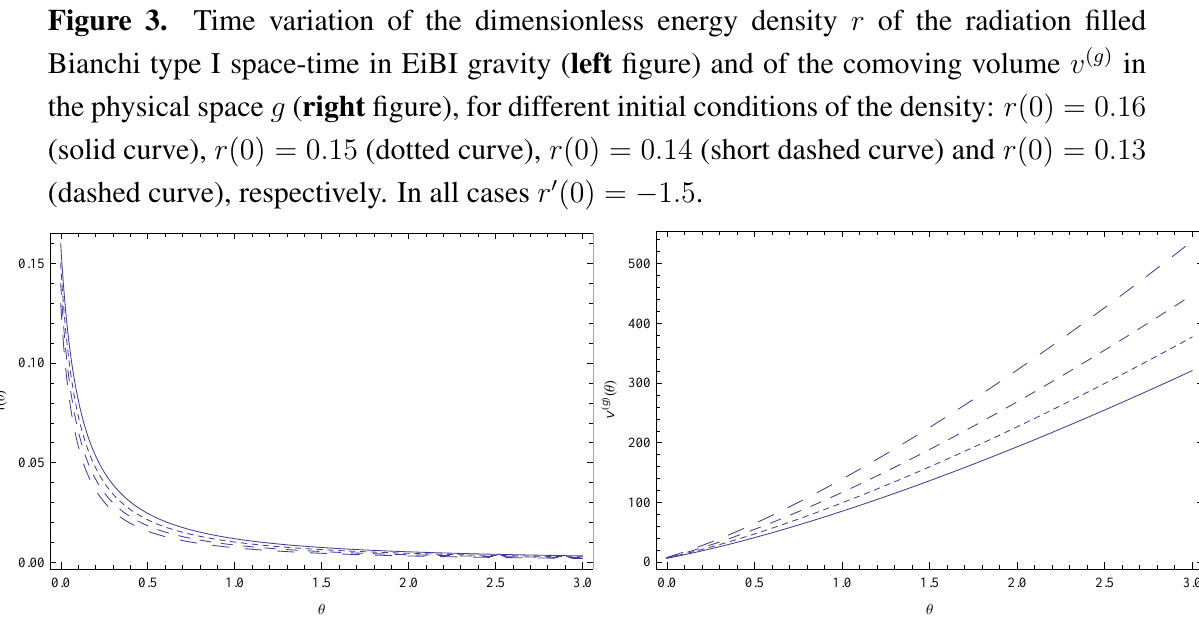
Figure 3. Time variation of the dimensionless energy density r of the radiation filled Bianchi type I space-time in EiBI gravity ( left figure) and of the comoving volume v ( g ) in the physical space g ( right figure), for different initial conditions of the density: r (0) = 0 . 16 (solid curve), r (0) = 0 . 15 (dotted curve), r (0) = 0 . 14 (short dashed curve) and r (0) = 0 . 13 (dashed curve), respectively. In all cases r (cid:48) (0) = − 1 . 5 .